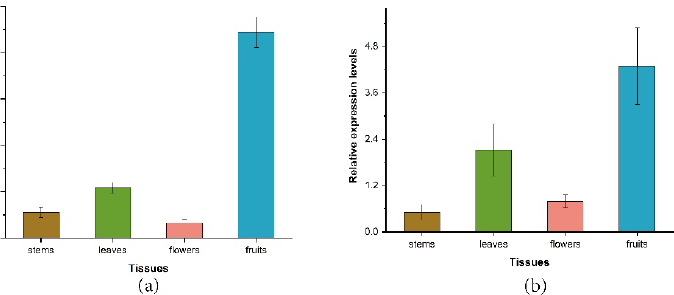
Figure 5. Expression analysis of the ZbDXS and ZbFPS genes in various tissues. ZbDXS expression levels in tissues ( a ). ZbFPS expression levels in tissues ( b ). Data presented are 2 −ΔΔCt levels calculated relative to the special tissue (root). Data are presented as mean ± SE, n = 3.